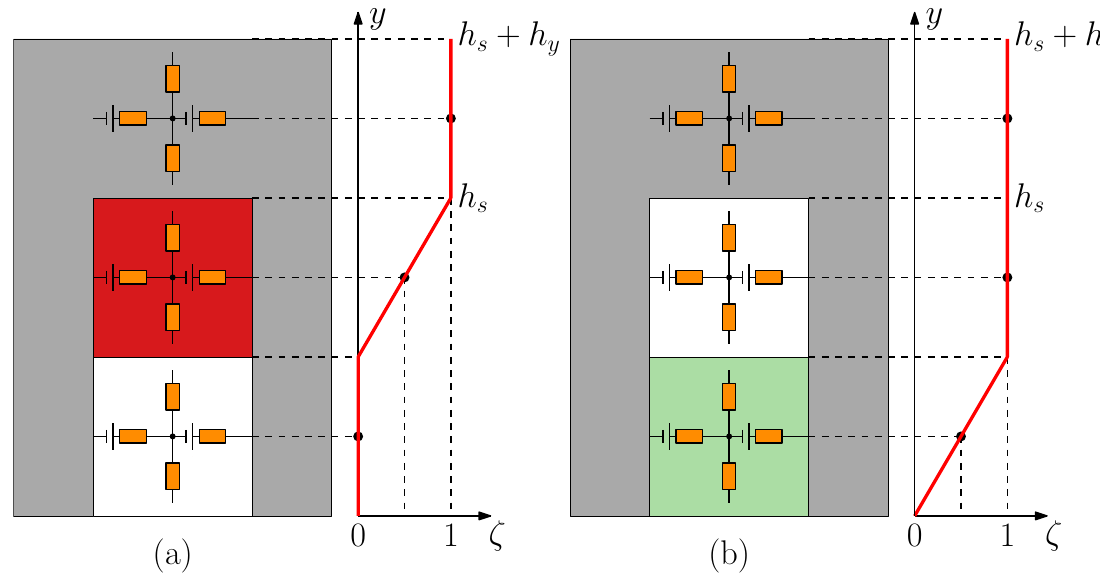
Figure 5. MMF-source distribution inside a single slot for ( a ) the top winding layer and ( b ) the bottom winding